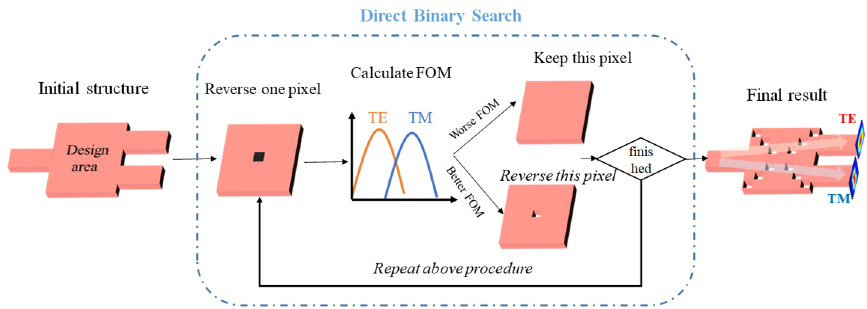
Figure 3. Schematic of DBS-assisted PBS design based on QR-code like structure.